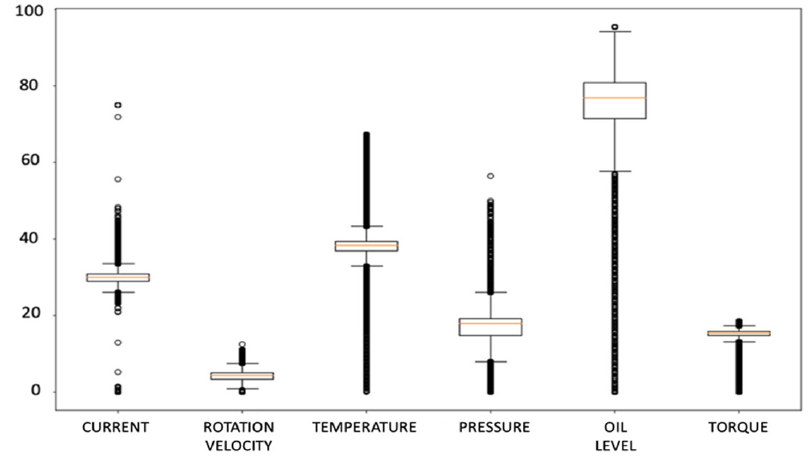
Figure 1. Boxplot of the original data.